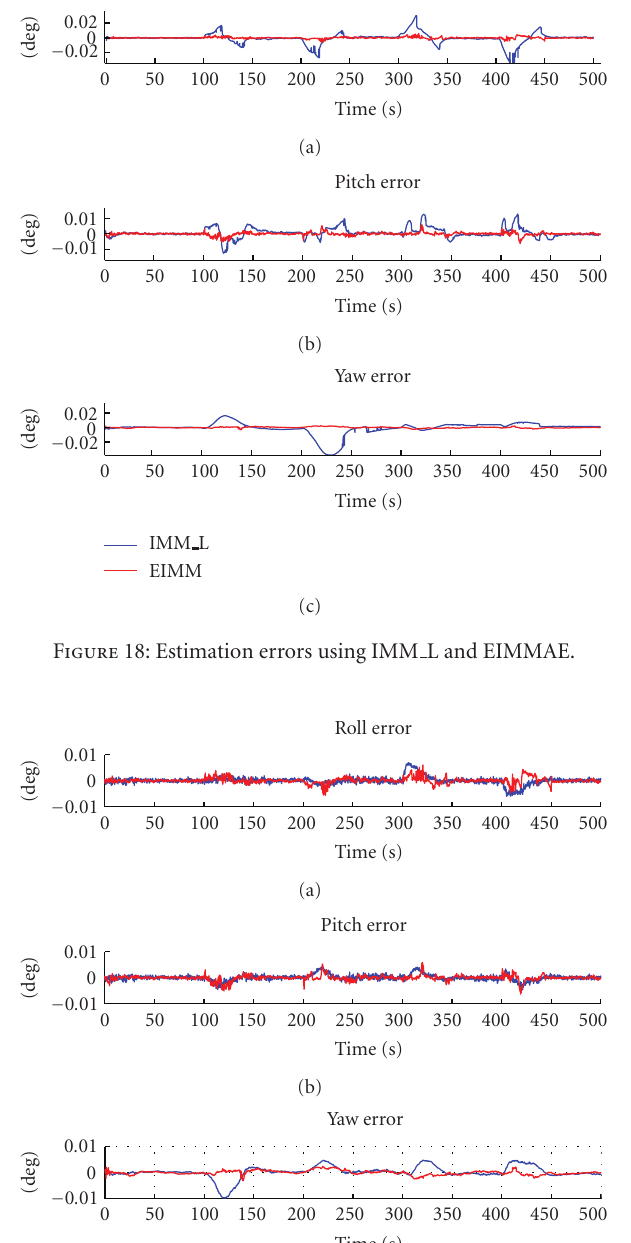
(IMM) extended Kalman filters (EKF) for attitude